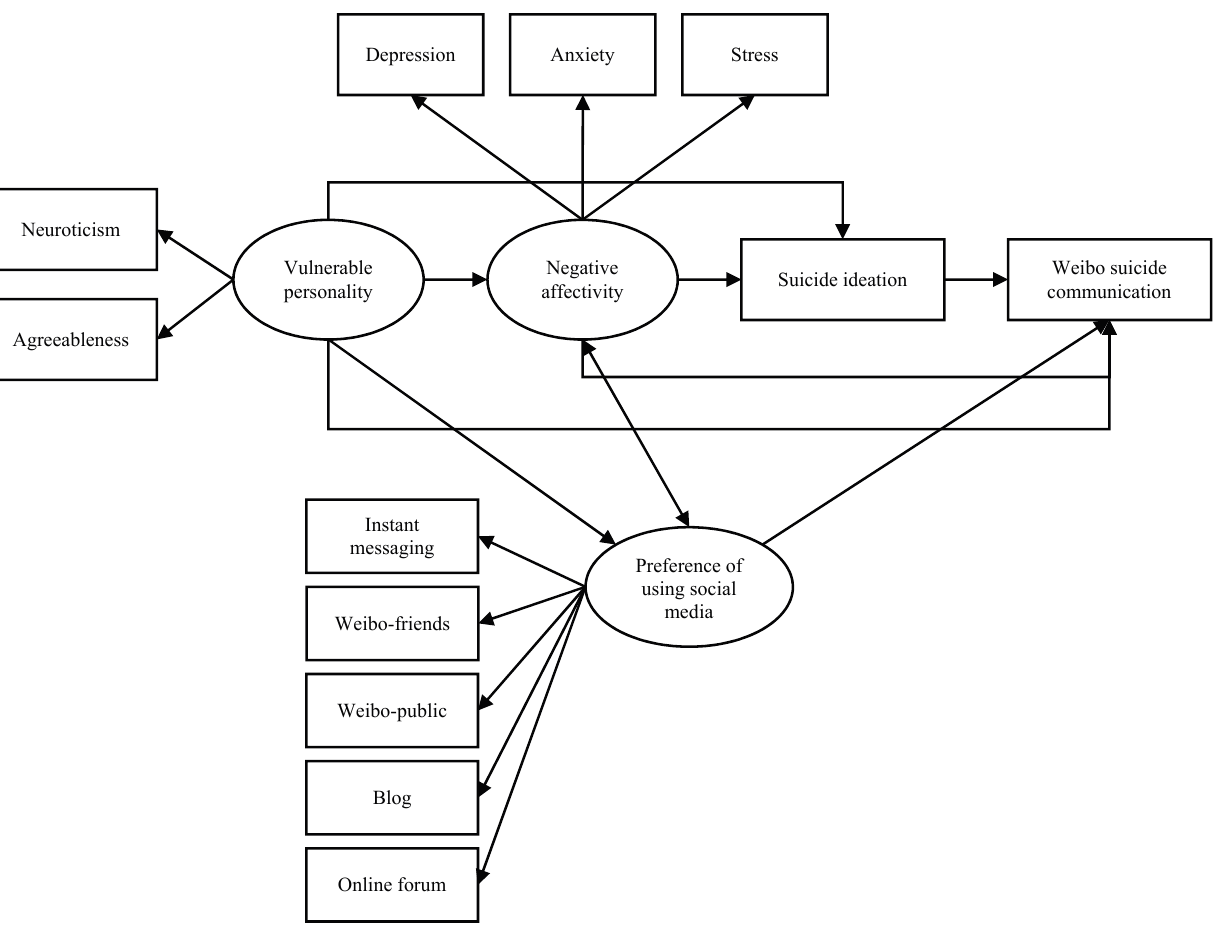
Figure 3. Model 3 based on the warning signs theory, the cry for help theory, and a preference for using social